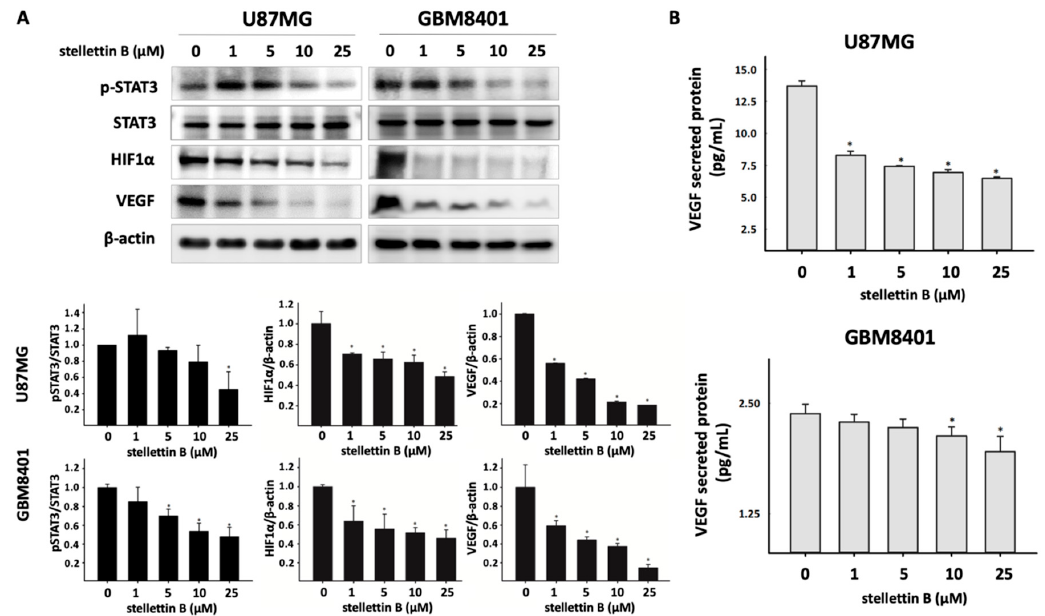
Figure 5. Stellettin B inhibits Stat3/HIF-1 α in VEGF expression and secretion in glioblastoma cells. ( A ) U87MG and GBM8401 cells were treated with 0, 1, 5, 10, or 25 µ M stellettin B for 24 h. Western blot analysis was performed to study the expression of pStat3, Stat3, HIF-1 α , and VEGF. β -Actin was used as a loading control. pStat3/Stat3, HIF-1 α / β -Actin, and VEGF/ β -Actin were quantified. Values are expressed as the mean ± SD ( n = 3). * p < 0.05 relative to controls. ( B ) VEGF secretion in U87MG and GBM8401 cells after 0, 1, 5, 10, or 25 µ M stellettin B treatment for 24 h. Secreted VEGF was measured using the Quantikine® Human VEGF immunoassay kit. Values are expressed as the mean ± SD ( n = 4). * p < 0.05 relative to controls.